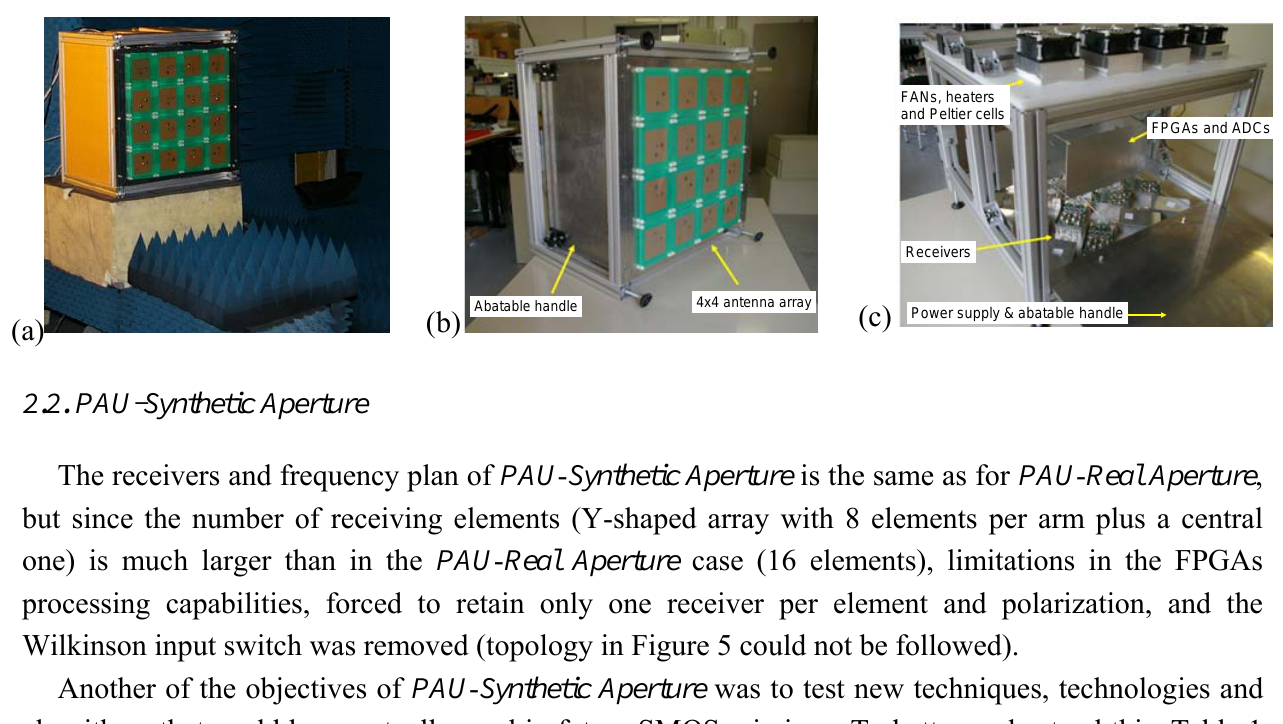
Figure 7. (a) PAU-Real Aperture without radome in UPC anechoic chamber for testing beamforming performance, (b) front view of the 4 × 4 element array, and (c) inside of the instrument showing the distribution of the dual-polarization receivers, FPGAs for data processing, and the temperature